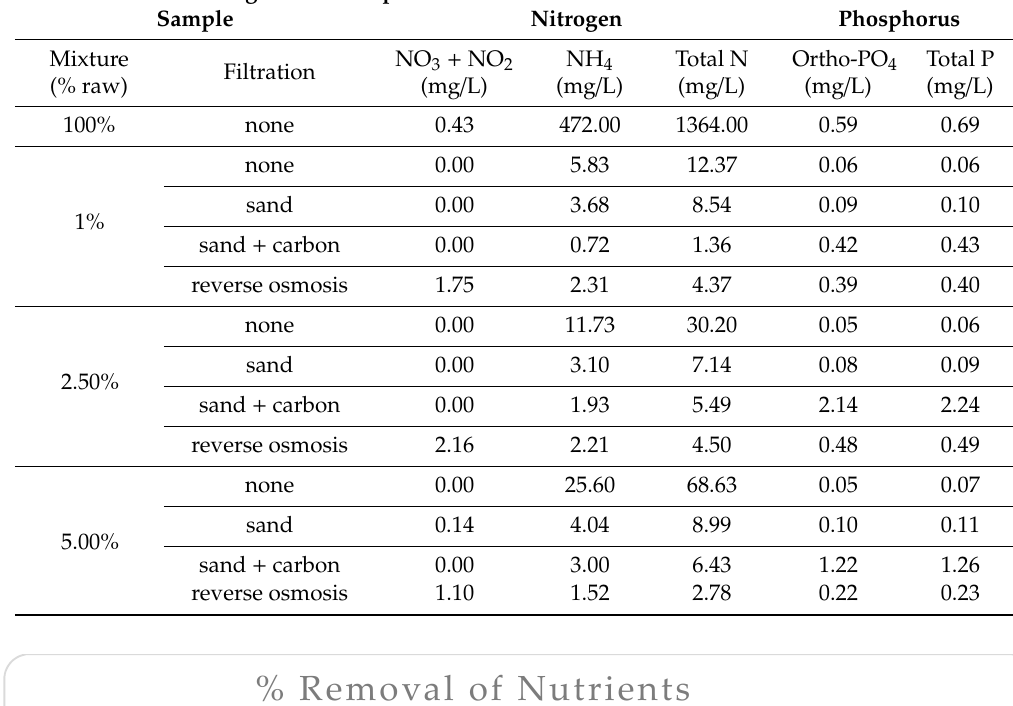
Table7. NitrogenandphosphorusconcentrationsintherawPHWWandtreatedPHWW.Concentrations